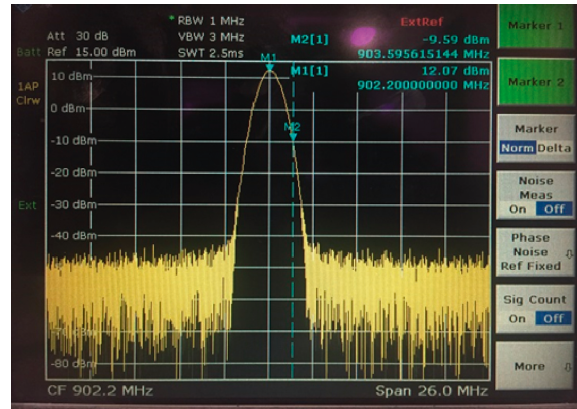
Figure 5: Noise source with TX power of 14dBm.